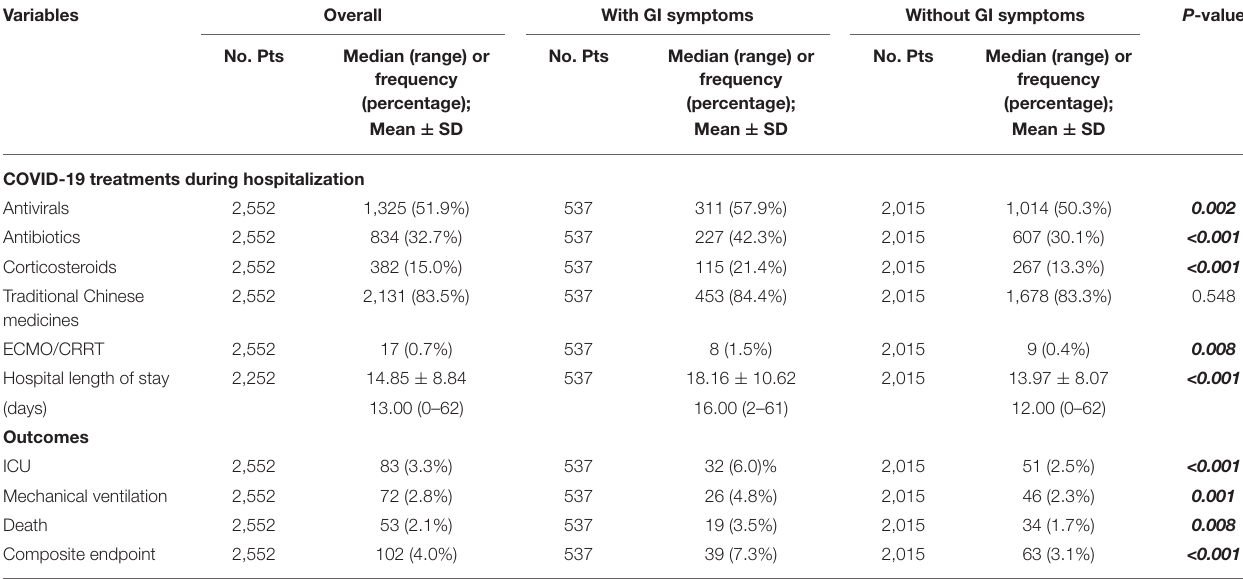
TABLE 2 | Treatment and outcomes of COVID-19 patients with and without GI symptoms. Variables